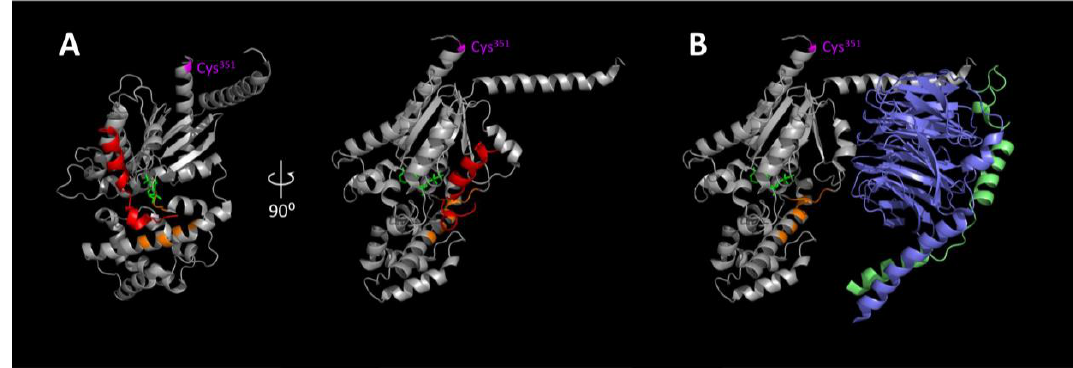
Figure 5. Crystal structures of Gα i -GDP in complex with GoLoco motif or Gβγ subunits. ( A ) Ribbon diagram of the Gα i -GDP in complex with GoLoco motif crystal structure in two views related by a 90° rotation about the vertical axis. The model of a full length Gα structure (residues 5-354) was constructed by combining published crystal structures of Gα i subunits (PDB entries 4G5R and 1GP2). Selected amino acids suggested to participate in GoLoco motif interaction (Tyr 69 , Val 72 , Ser 75 , Gln 79 , Val 179 and Thr 181 ; Jia et al., 2012) are highlighted in orange . Gα i and GoLoco peptide are shown in light gray and red , respectively. The PTX ADP-ribosylation site (Cys 351 ) is highlighted in magenta . GDP is shown in the ball-and-stick model ( green ). ( B ) Ribbon diagram of the Gα i -GDP in complex with Gβγ subunits crystal structure. Gβ and Gγ subunits are shown in blue and lime . The color scheme of Gα i is the same as in A .